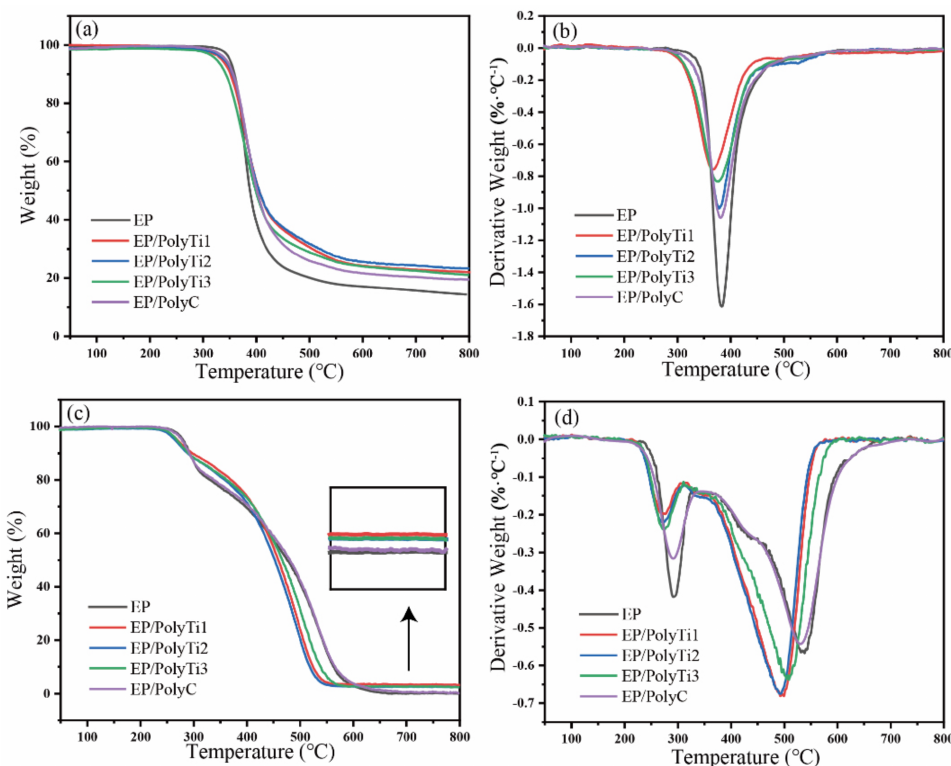
Figure 12. TGA results of the epoxy composite materials in N 2 ( a , b ) and air ( c , d ) atmospheres.